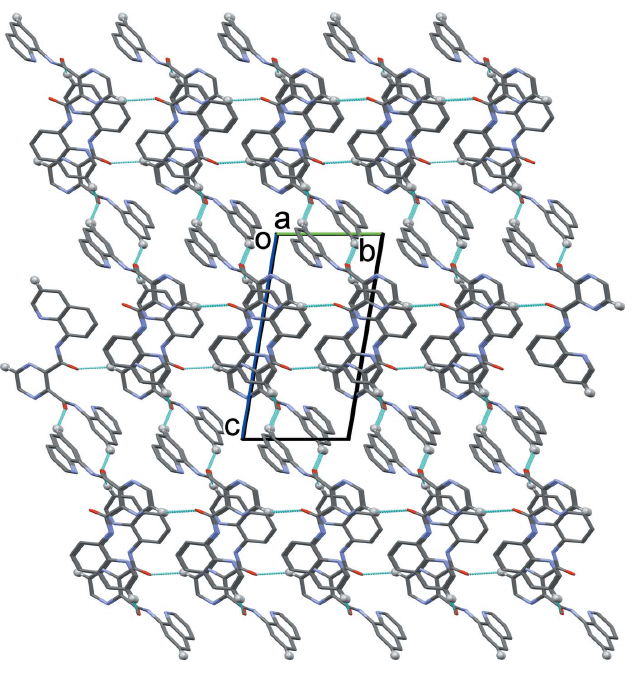
inated acetonitrile molecule on atom Cu2 (Table 4).